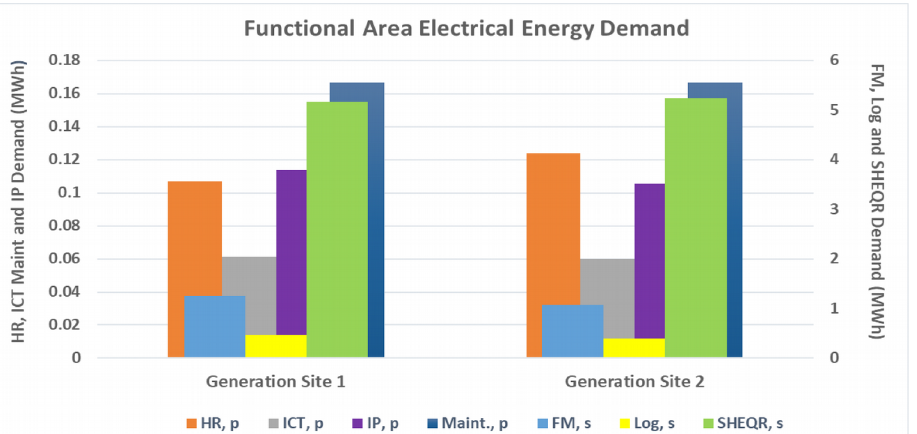
Figure 5. Electrical energy demand of the various functional areas at each generation